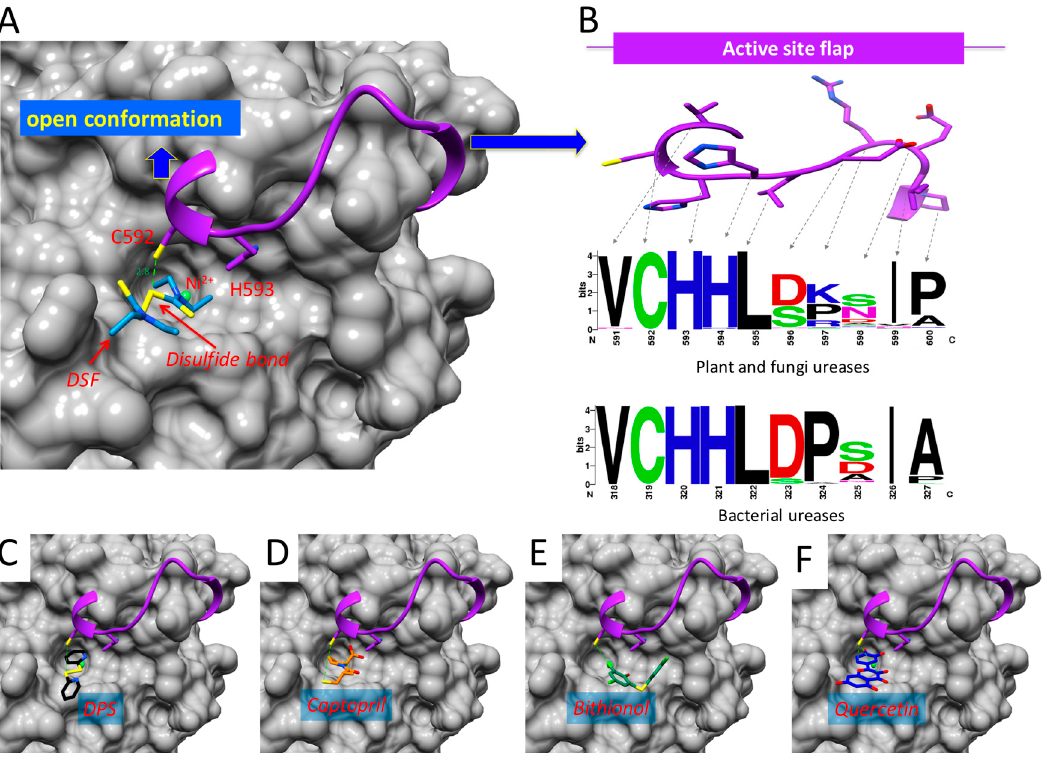
Figure 5. Binding model of DSF and other reactive compounds to urease. ( A ) Model of the binding of DSF to JBU enzyme showing the interaction with Cys592 (dashed line, distance in Å). Ni 2+ ions are shown in ball representations, active site flexible flap is shown in cartoon representations with Cys592 and His593 depicted in stick models and the rest of JBU is in surface representation. ( B ) Frequency of residues present in the active site flexible flap. The multiple alignment of urease enzymes available in Data Bank was used to plot frequencies in the logo. The amino acid residues are depicted as color code on the basis of their physicochemical properties as stated default it the weblogo server (http://weblogo.berkeley.edu/logo.cgi: polar amino acids (G,S,T,Y,C,Q,N) are green, basic (K,R,H) blue, acidic (D,E) red and hydrophobic (A,V,L,I,P,W,F,M) are black). ( C ) Model of the binding of DPS ( D ) Captopril; ( E ) Bithionol and ( F ) Quercetin to JBU. All structural images were generated using USCF-Chimera and are represented in a similar way to A.